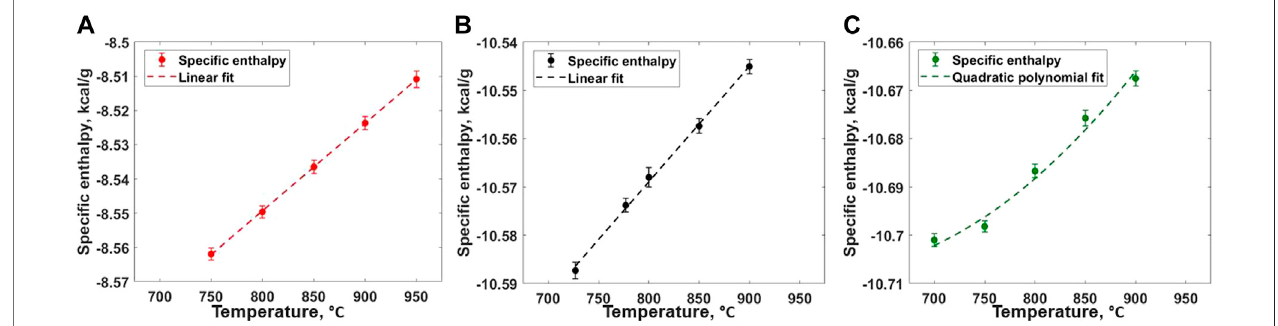
FIGURE 11 | Speci fi c enthalpy of salt melt for (A) Composition A (B) Composition B, and (C) Composition C as obtained from RIM-IPMD calculations.